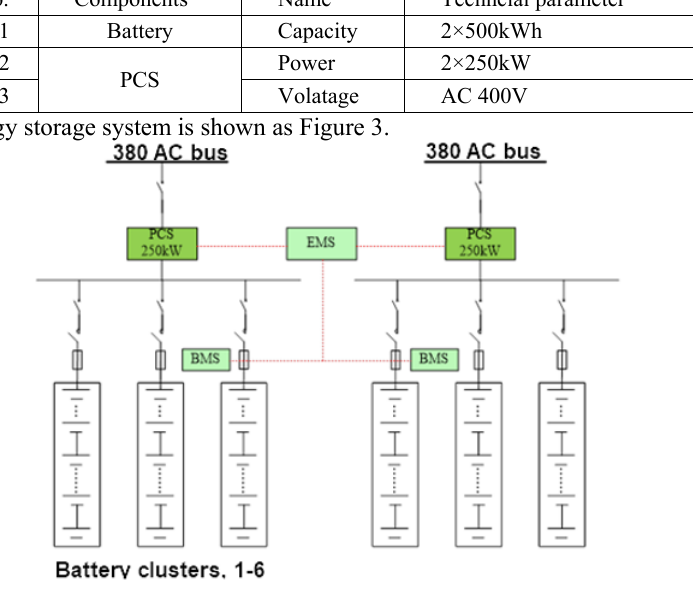
Fig. 4. 250kW/1000kWh energy storage system.